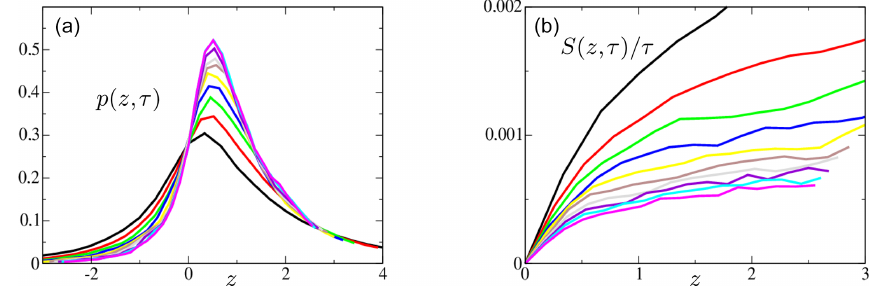
Figure 2. The pdf p(z,τ) (a) and the symmetry function normalized by the averaging time S(z,τ)/τ (b) as a function of z for different averaging times τ (see caption and legend of Fig. 1); data are from GSE, res 0.5 ◦ , 1993–2016, res 6h.